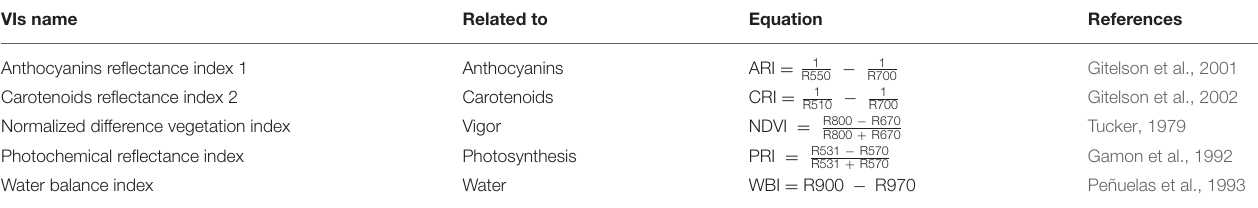
TABLE 2 | Common vegetation indices (VIs) from the literature that were used in this work.